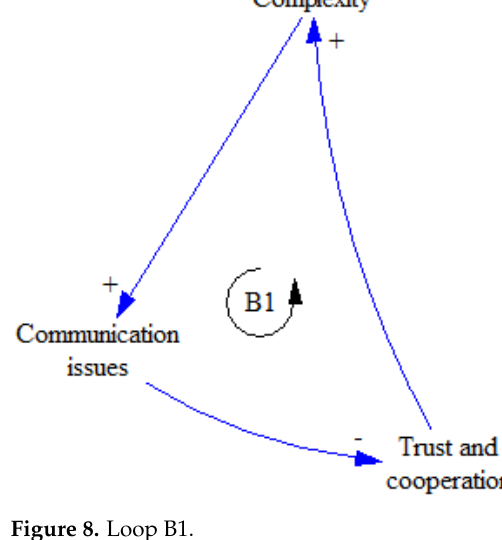
Figure 8. Loop B1.